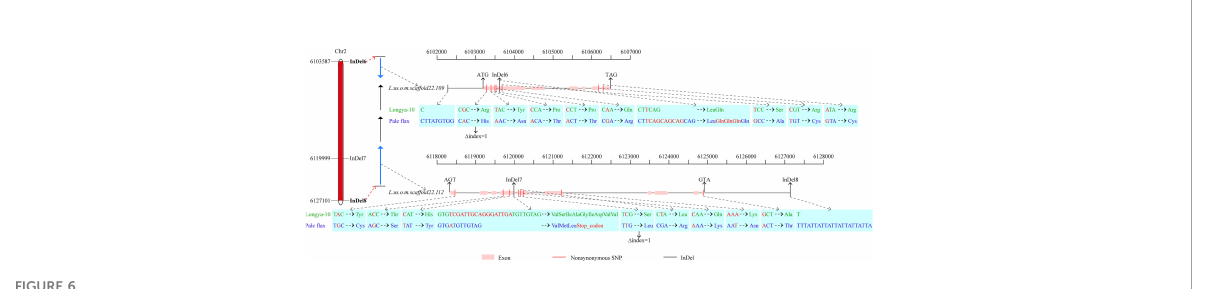
FIGURE 6 Fine-mapping interval of GH2.1 and possible candidate genes within the region. The left bar shows the physical map of GH2.1 . The middle arrow diagram display the genes in GH2.1 , in which blue arrow indicate the genes L.us.o.m.scaffold22.109 and L.us.o.m.scaffold22.112 , which contained nonsynonymous SNPs with D index=1. The right section exhibits the variation sites of L.us.o.m.scaffold22.109 and L.us.o.m.scaffold22.112 between Longya-10 and pale fl